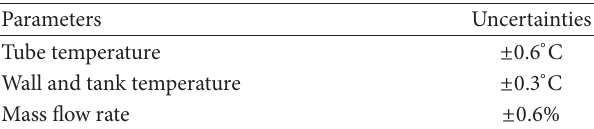
Table 1: Uncertainties of measured parameters.